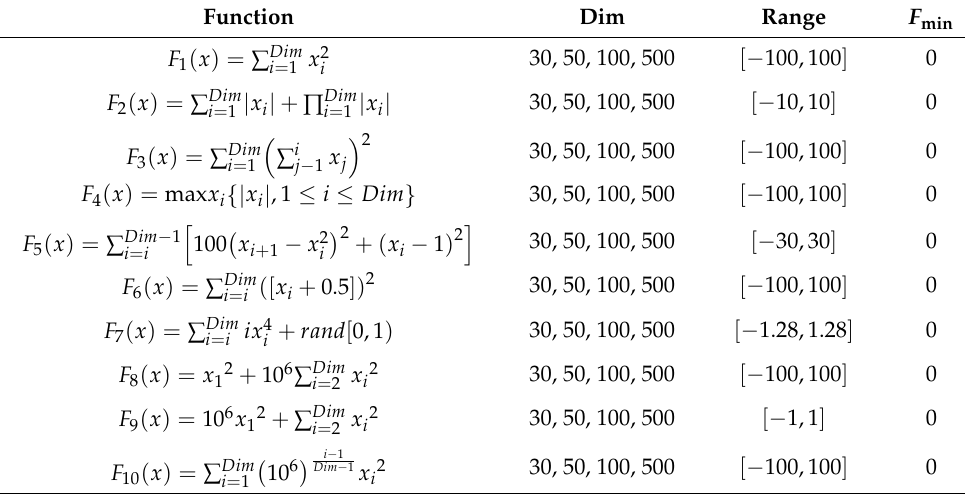
Table 1. Unimodal benchmark